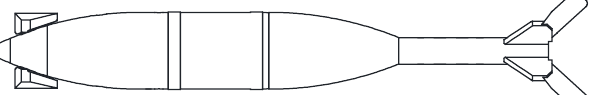
inertia are 15.0 kg, 0.387 m, 0.0261 kg-m 2 , and 0.70 kg-m 2